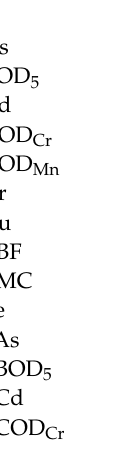
timization; Table S2: GEF1 IN Fuzzified Values Rules Optimization; Table S3: GEF2 IN Fuzzified Values Rules Optimization; Table S4: SCW1 IN Fuzzified Values Rules Optimization; Table S5: SCW2 IN Fuzzified Values Rules Optimization; Table S6: EBF OUT Fuzzified Values Rules Optimization; Table S7: GEF2 OUT Fuzzified Values Rules Optimization; Table S8: SCW1 OUT Fuzzified Values Rules Optimization; Table S9: SCW2 OUT Fuzzified Values Rules Optimization. These are the complete lists of the rules optimization table for the five bioretentions for both IN and